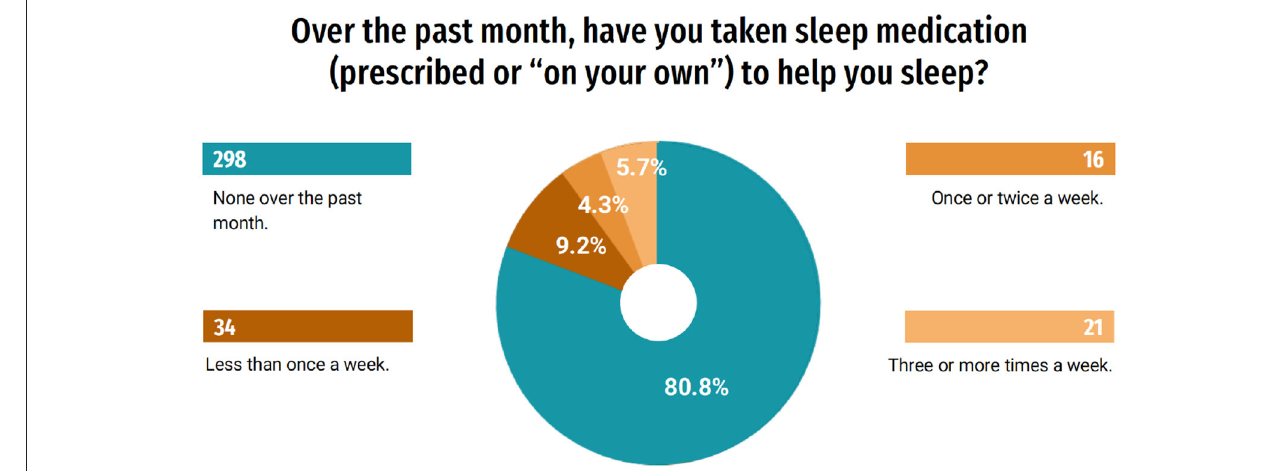
FIGURE 7 | Medication to help going to sleep.